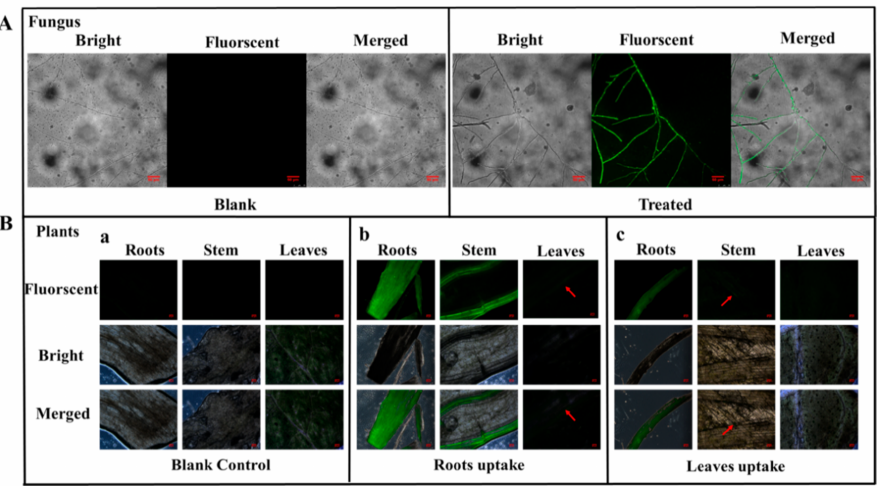
Figure 8. Confocal imaging of Rhizoctonia solani incubated with BMMs − PMA/5-AF for 10 days ( A ). Fluorescence microscope images of different parts of the tomato plant (leaves, stems, and roots) after 1 day of treatment with BMMs − PMAA/5-AF for the roots ( B-b ) and the leaves ( B-c ) compared to a blank control ( B-a